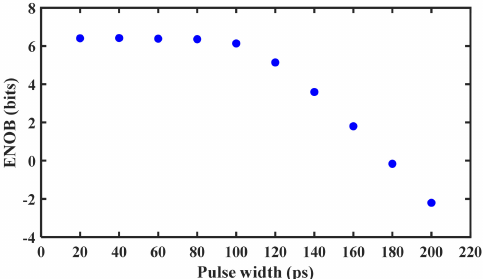
Figure 12. Non-uniform optical pulse train with residuary optical pulses selected from a high-speed uniform optical pulse train with a repetition frequency of 20 GHz.